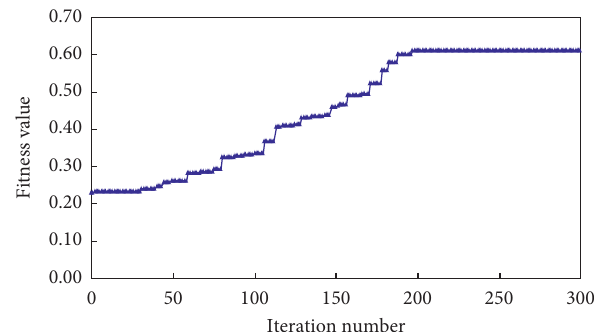
Figure 8: Convergence process of fitness values.